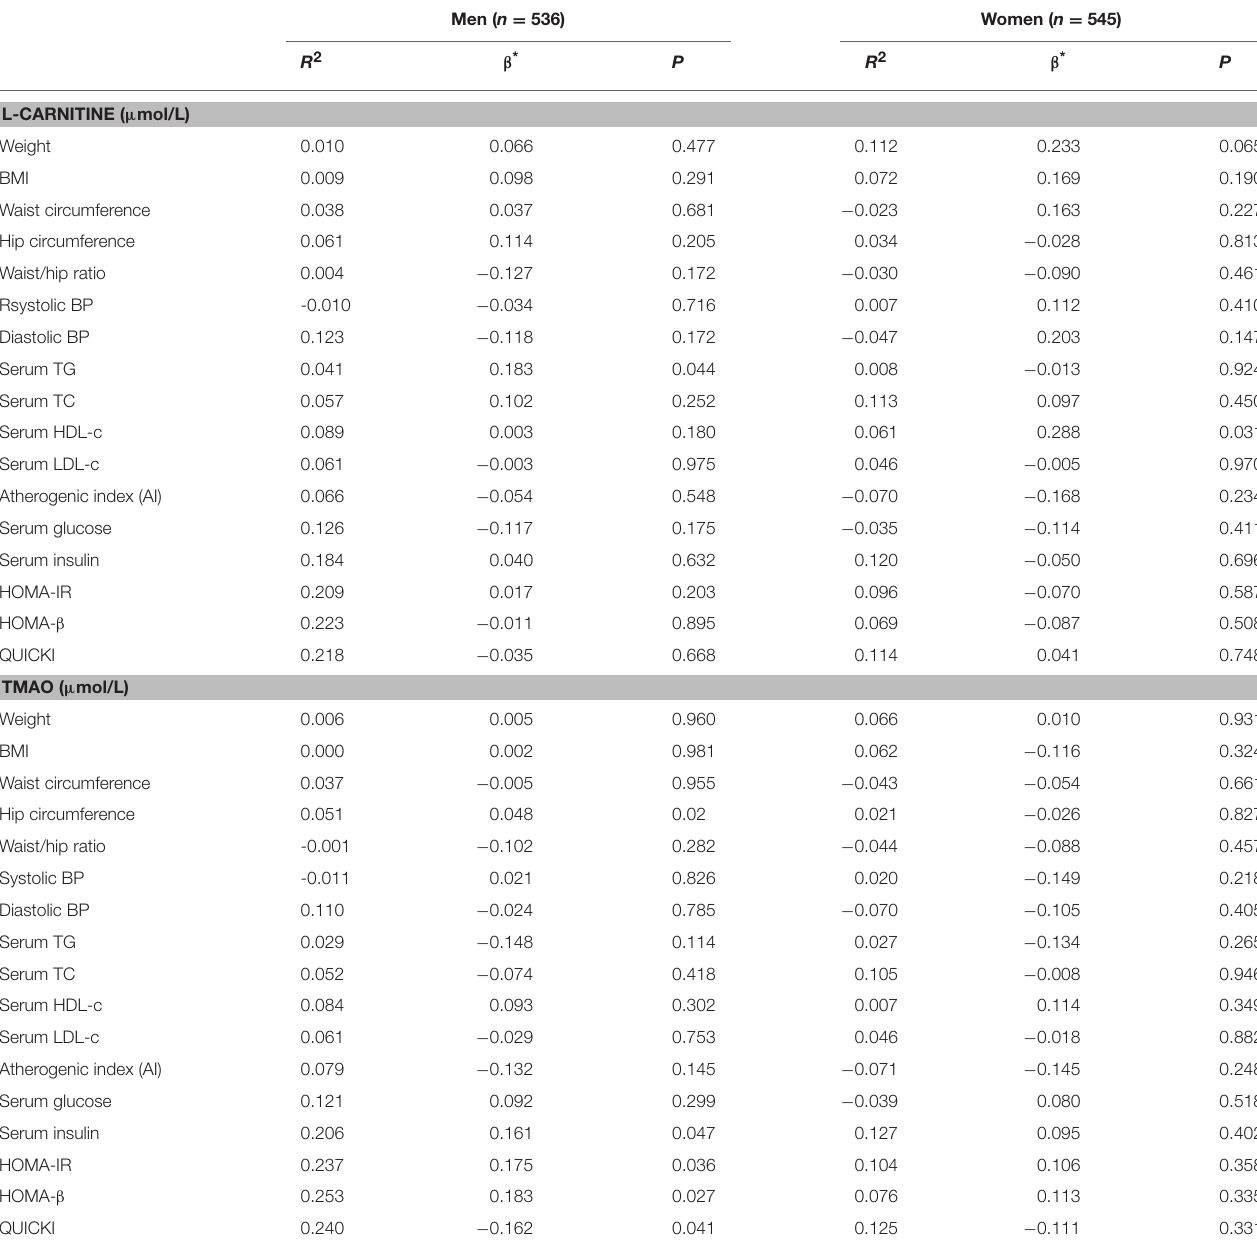
TABLE 7 | Linear regression analysis of serum L-carnitine, TMAO levels with metabolic syndrome related indexes in subjects with hyperglycemia a